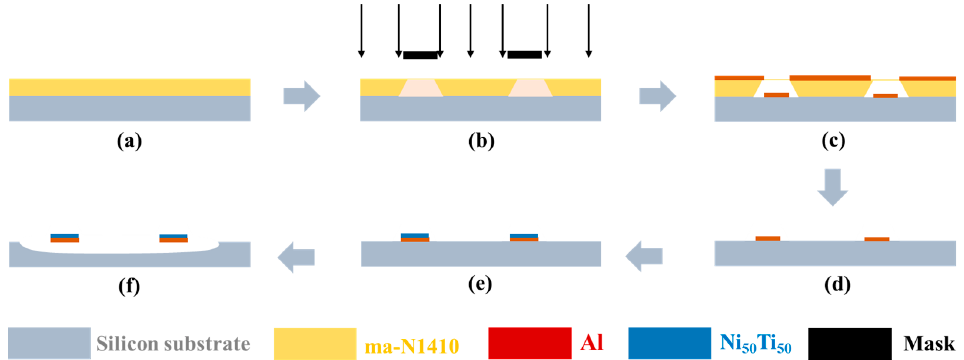
Figure 12. Fabrication process of the prototype of a solar sail beam structure. ( a ) ma-N1410 spin coating; ( b ) Photolithography; ( c ) Development and Al sputtering; ( d ) Lift-off for Al layer; ( e ) Sputtering Ni50Ti50 onto Al; ( f ) XeF2 Dry etch.